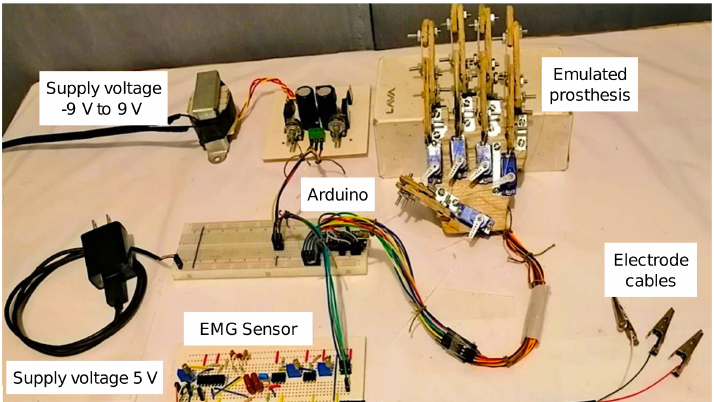
Figure 9. Experimental platform for a bionic − hand prosthesis.